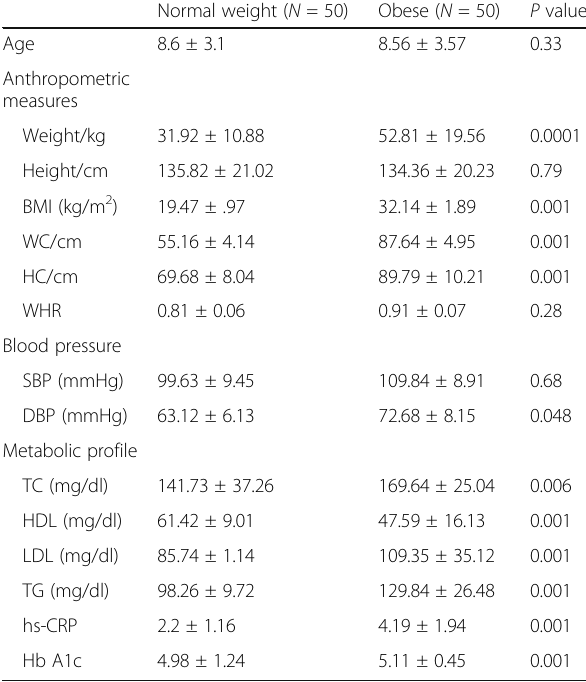
Table 2 Statistical differences in anthropometric measures, blood pressure, and metabolic parameters in normal weight and obese